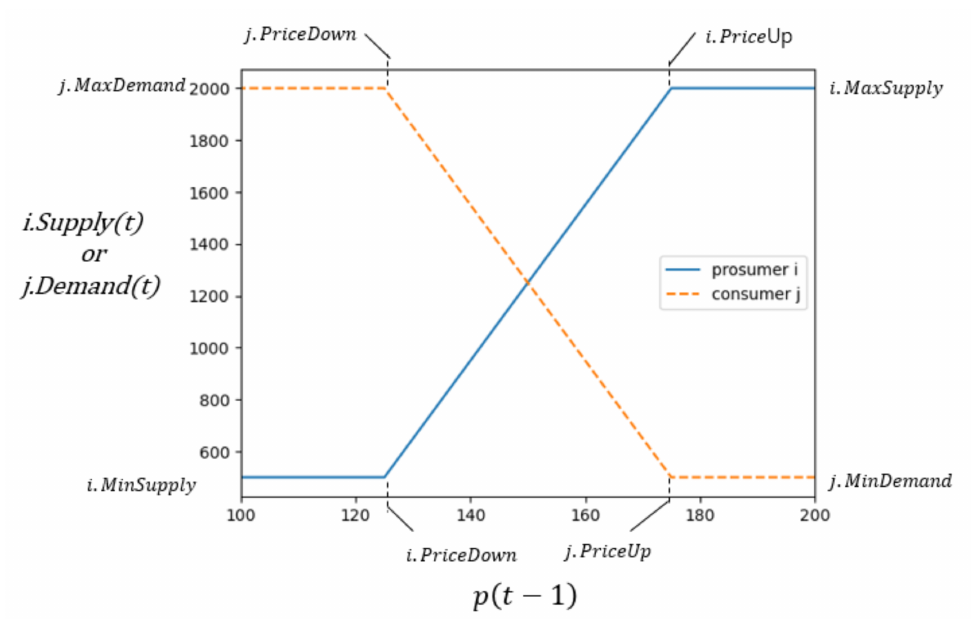
Figure 11. An illustration of ( i . Supply ( t ) or j . Demand ( t ) ) vs. p ( t − 1 )